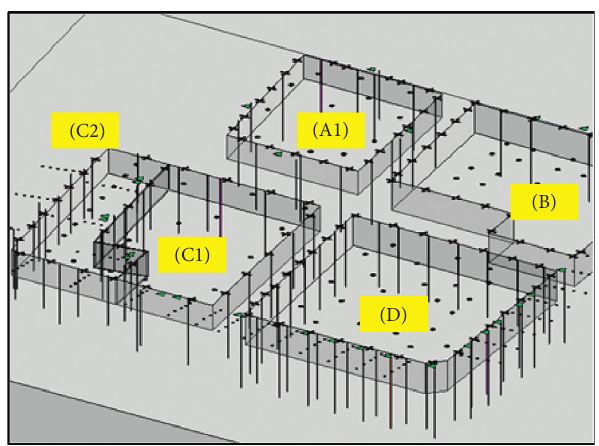
Figure 8: Recording of instrumentations arrangement of the Expo Project with Revit.